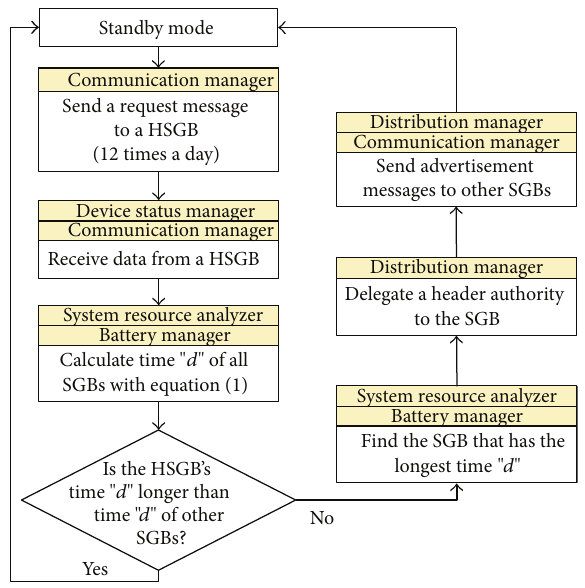
Figure 6: Flowchart of energy-efficient cooperation-based opera- tion of a smart garbage